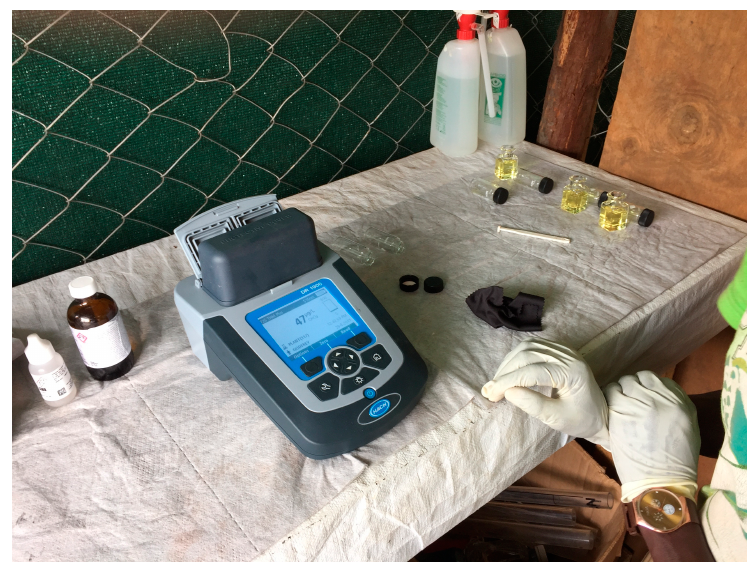
Figure 2. Hach THM Plus Method kit set up at the on-site Palorinya SWTP water quality lab (Source: Syed Imran Ali).